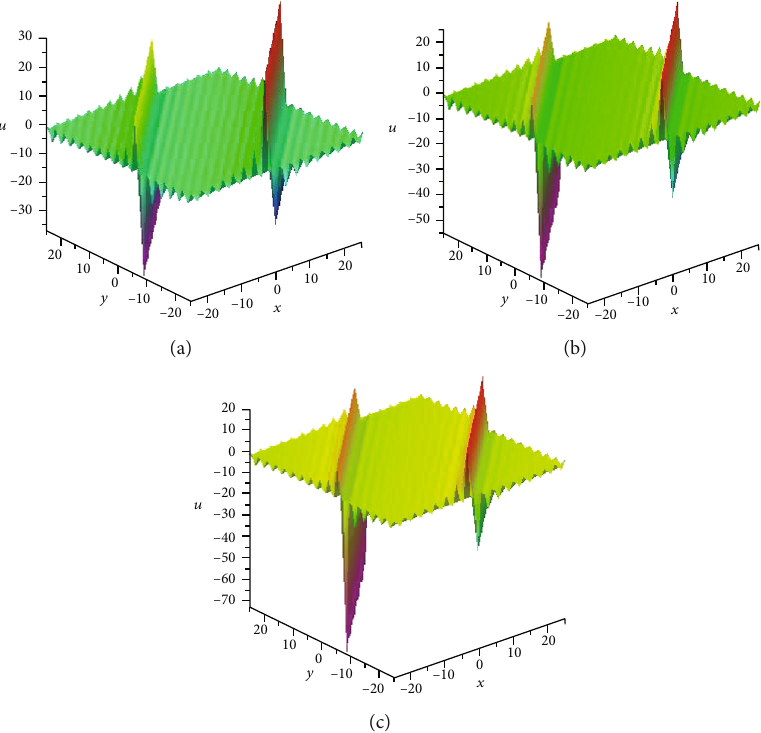
Figure 3: Evolution of Equation (63) at (a) t = 0 : 293 , (b) t = 0 : 2938 , and (c) t = 0 : 2942